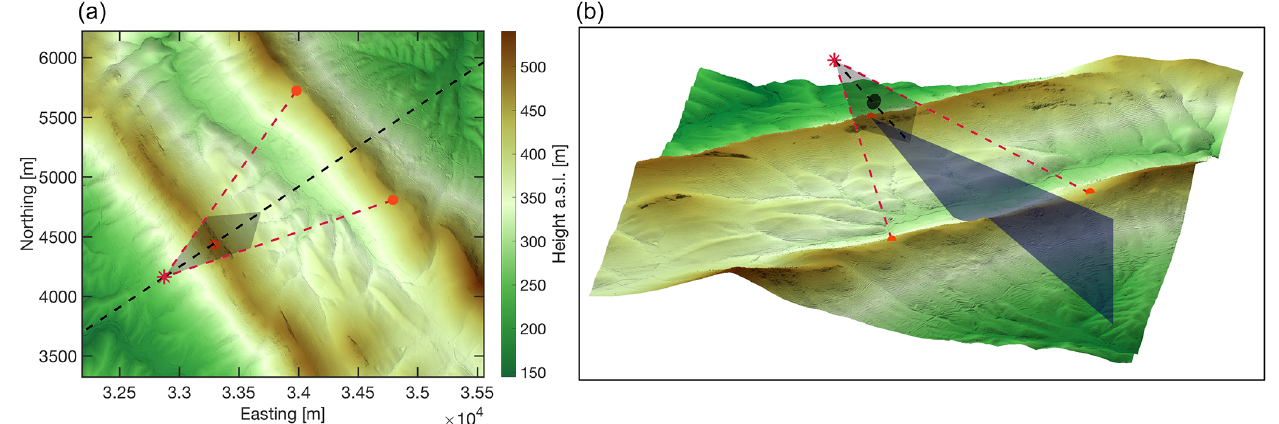
Figure 1. Overview of the terrain and scanning trajectories. Coordinates expressed in ETRS89/PTM06 and height above sea level. Red points: location of long-range WindScanners; blue plane: RHI scan; black circle: rotor plane; black plane: diamond scan plane; black dashed line: wind turbine transect or line of synchronized measurements in diamond scan; red dashed line: example of beams doing a measurement. Panel (a) : top view; panel (b) : tilted view.